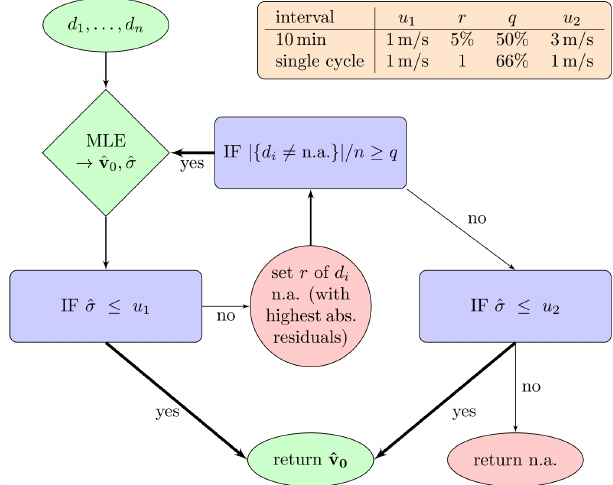
Figure 5. Schematic flowchart of the DWL retrieval with the main steps to determine the wind vector estimate ˆ v 0 . All measurements d 1 ,...,d n from a given height and in a given time interval pass through the iteration loop. “If” statements (blue) use thresholds ( u 1 , u 2 , and q ) to decide whether to set n.a. values (red) or pass wind- fit data (green). The thresholds depend on whether the time interval is 10min or consists only of the measurements of a single DWL cycle (see orange